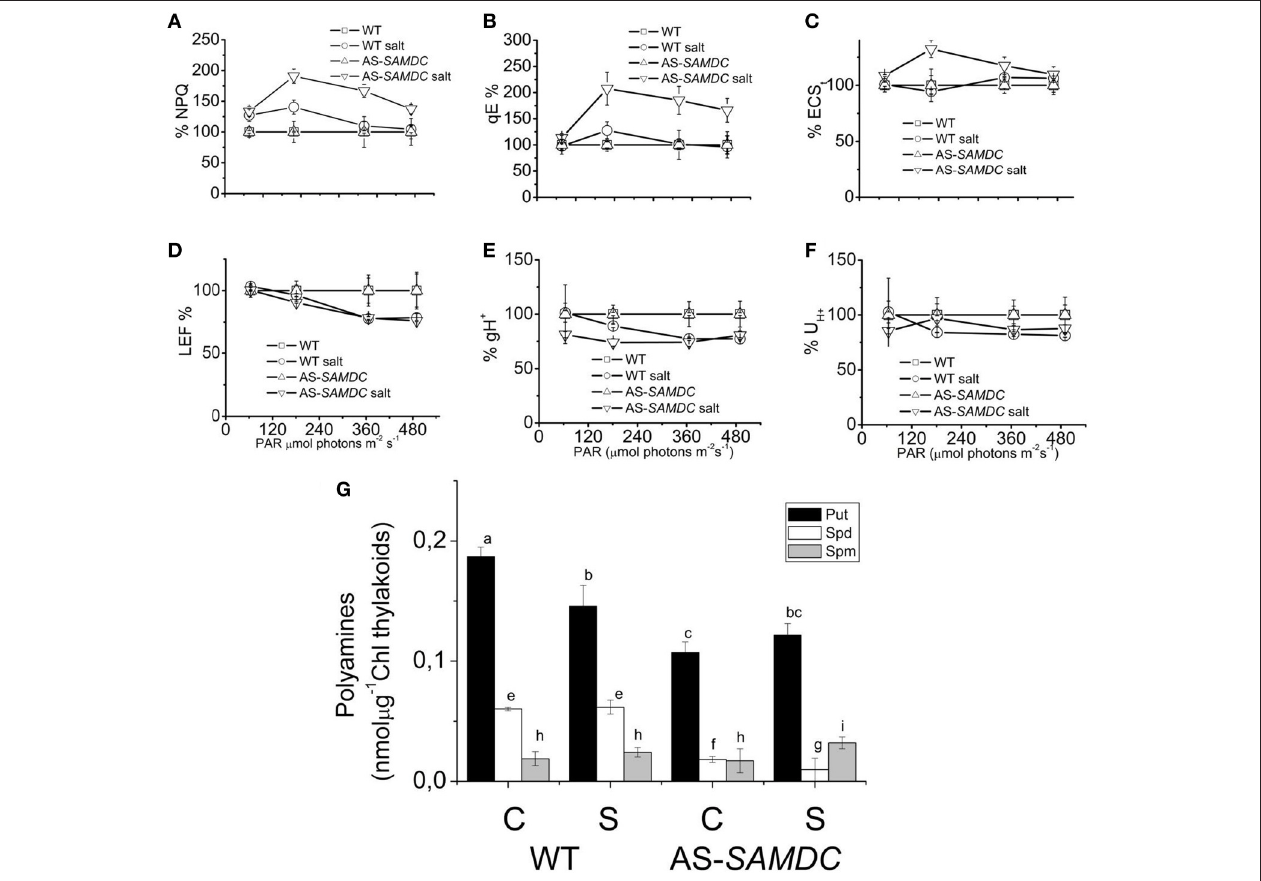
FIGURE 6 | Photosynthetic parameters and PA titers in WT and AS- SAMDC plants grown in perlite 24 h post-treatment with 200 mM NaCl at different light intensities. (A) Non-photochemical quenching (NPQ) at four different light intensities (0, 64, 181, 366, and 490 µ mol photons m − 2 s − 1 ). (B) High energy quenching (qE). (C) Light-induced proton motive force estimated as electrochromic shift in thylakoids. (D) Linear electron flow (LEF) at four different light intensities. (E) Apparent conductivity of the thylakoidal ATPase to protons (gH + ). (F) Total proton flux from lumen to stroma (U H + ). Data in (A–F) are means ± SE ( n > 3). Error bars denote standard error ( n > 3). Steady state photosynthesis in WT and AS -NtSAMDC estimated in intact plants treated with high dose of NaCl and control plants. (G) Thylakoidal PA levels. Data are means ± SE of three biological replicates. Different letters indicate significant difference (Student’s t -test, P < 0.05).